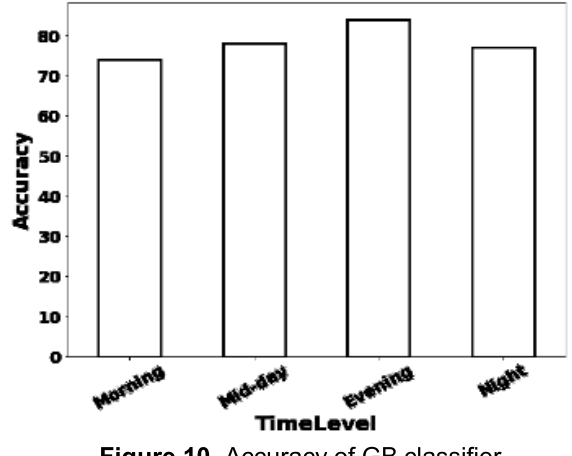
Figure 10. Accuracy of GB classifier algorithm at different times.